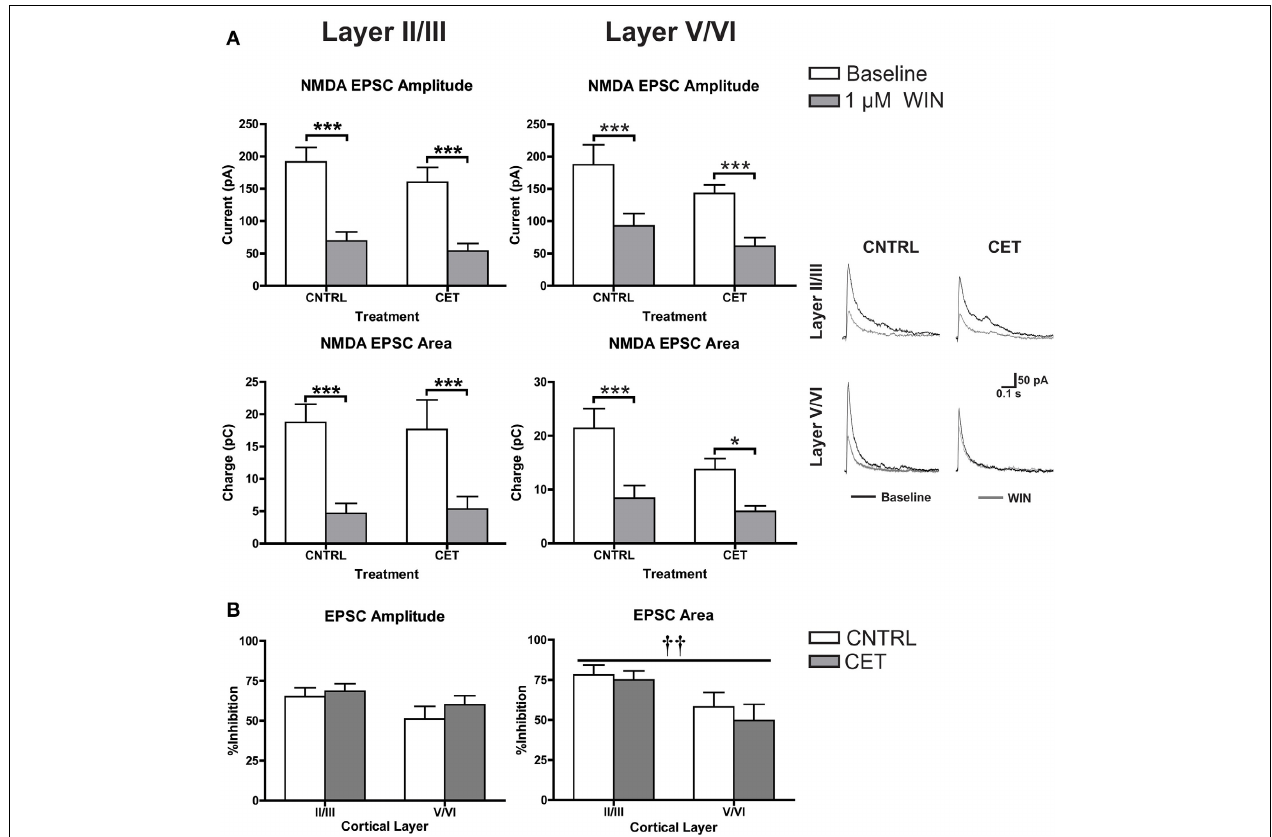
FIGURE 5 | CB1-mediated inhibition of glutamatergic transmission is not altered by CET. (A) The effect of WIN on evoked NMDA EPSCs recorded from layer II/III and layer V/VI PNs in control and CET cultures ( N = 8–9). White bars represent baseline measures and gray bars represent EPSCs recorded following a 10min application of WIN (1 μ M). The traces to the right are representative examples from each of the four groups. Traces in black are baseline, and the superimposed gray traces are from the same neurons in